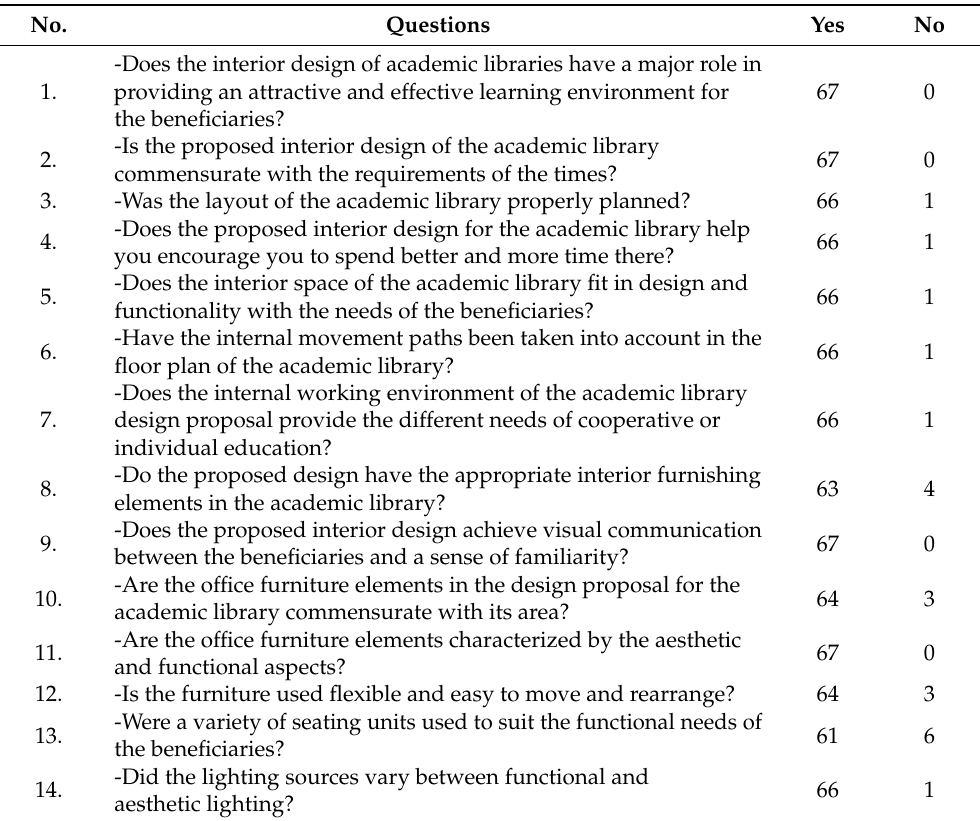
Table A2. Opinion poll on the proposed interior design for the academic library, College of Education, King Faisal University from the point of view of the